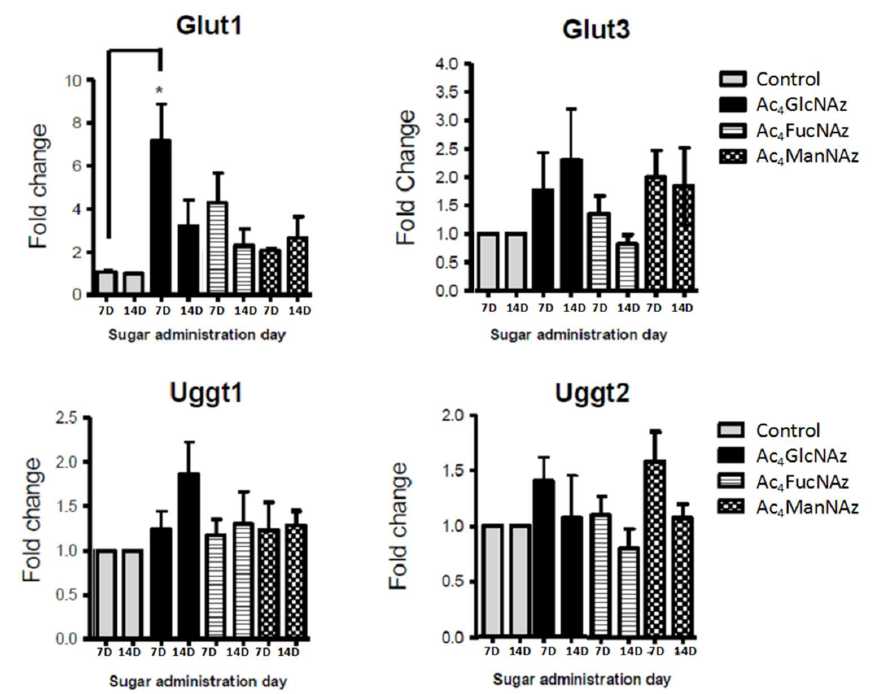
Figure 5. Glucose transporters and transferases gene expression after 7 and 14 days in culture (7D and 14D). * p < 0.05 indicates a statistically significant difference.